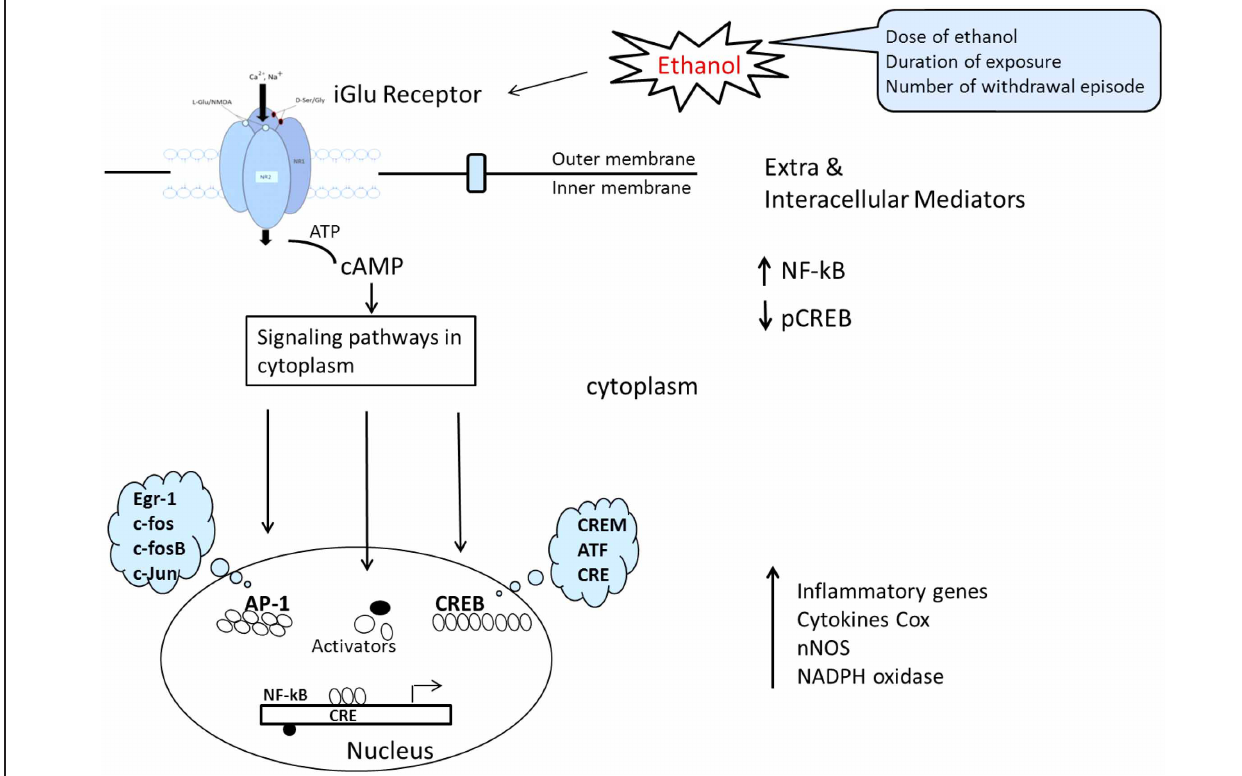
signaling and an increase in NF- κ B signaling. Finally CREB is able to regulate the transcription of downstream target genes and leads to imbalance between procytokine-oxidative stress and pro-survival gene transcription. [The model was adapted and modified from Johnston (2003) and Cao et al.